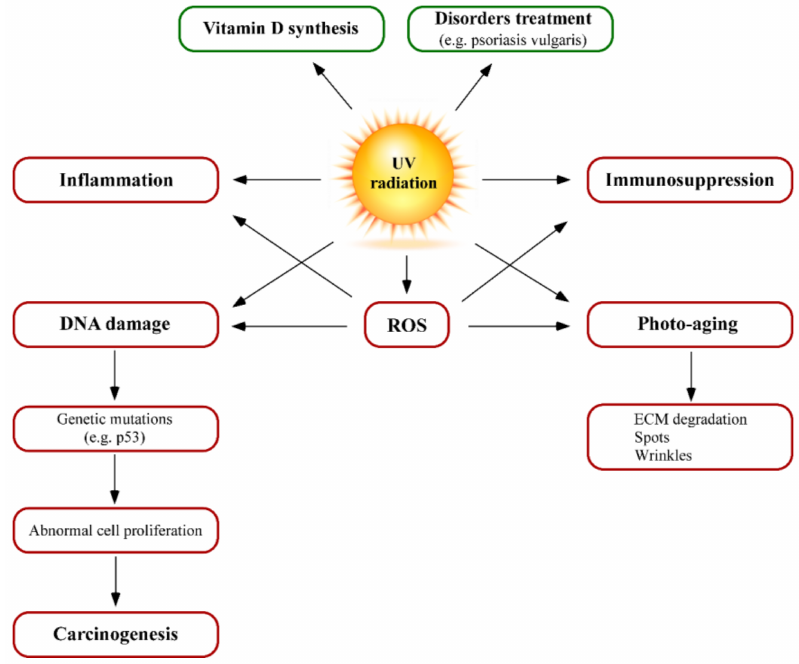
Figure 3. Summary of UV irradiation effects on the skin: positive (green) and adverse effects (red).